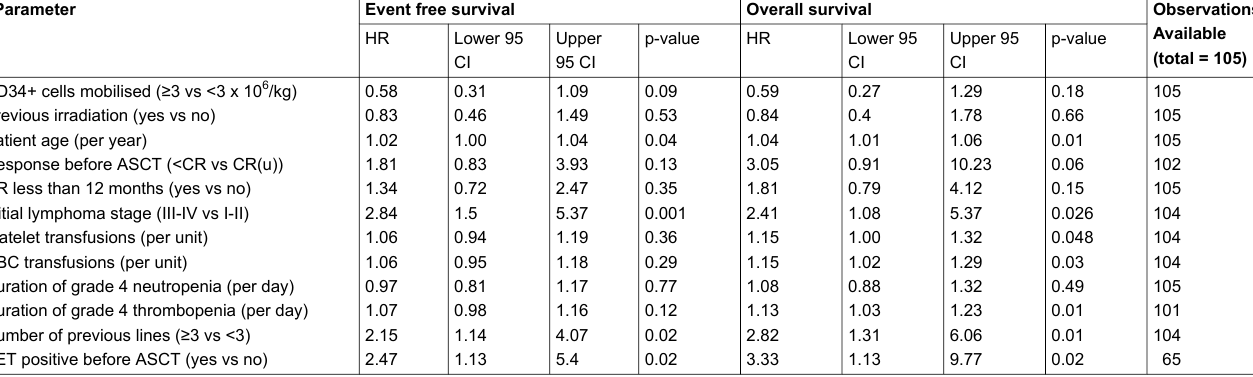
Table 4 : Prognostic factors for event free and overall survival by univariate Cox proportional hazards analysis in diffuse large B cell lymphoma and Hodgkin’s lymphoma patients.